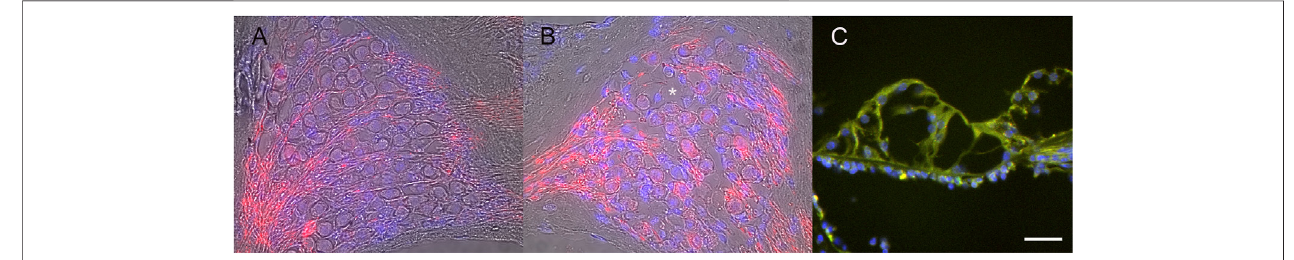
FIGURE 3 | Use of an Ad28 vector (Ad28.hcmv.gfp) did not decrease neuronal survival in normal hearing inner ears (A) and conversely did not support survival on spiral ganglion cells after ototoxicity (B) . Asterisk in B marks empty vacuole due tolost spiral ganglion neuron. There isexpression of GFP in the neomycin-treated organ of Corti after delivery of Ad28.hcmv.gfp (C) . Scale bar = 20 µm (A,B) , 10 µm (C)